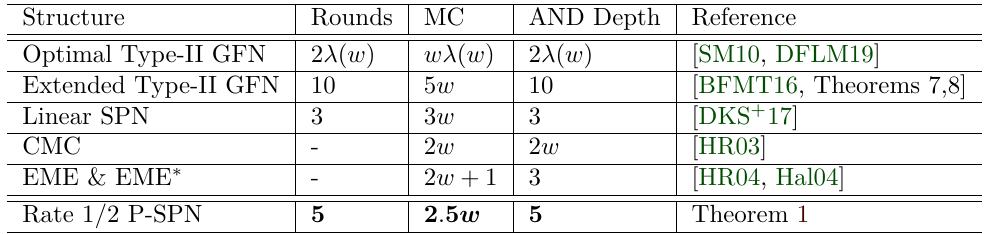
Table 1: Comparison to existing wide SPRP structures. The Rounds column presents the number of rounds sufficient for birthday-bound security, where λ ( w ) = d log For Type-II GFN (i.e., GFNs with w/ 2 block functions per round, see Fig. 1 (b)), note that 2 λ ( w ) = 2 d log 1 . 44 w e ≥ 6 when w ≥ 4. Parameters in the MC and AND 2